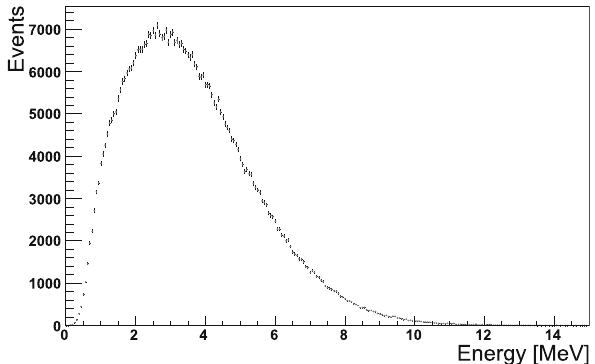
Fig. 13 Time difference between prompt and delayed events for IBD